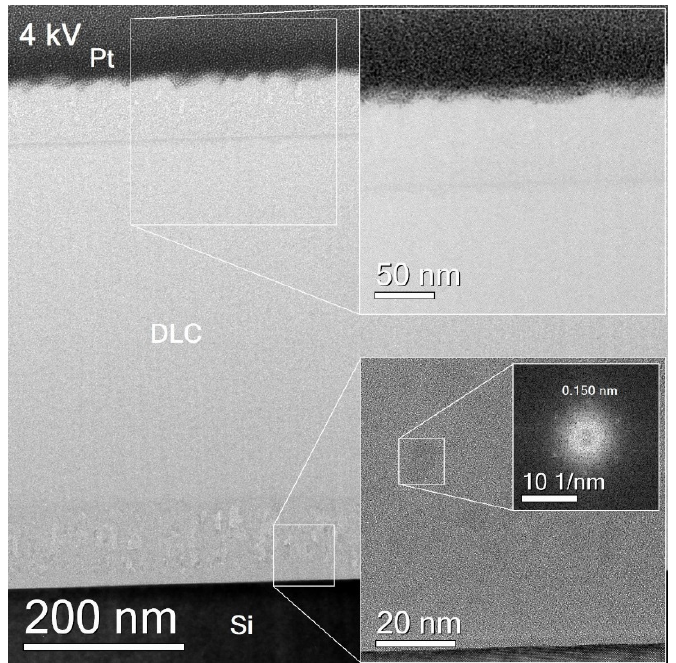
Figure 7. Cross-sectional TEM analysis of a DLC coating produced with 4 kV in region (b) referring to Figure 3. Magnified insets of the interfaces are shown along with a Fourier transformation of the boxed area in the lower right